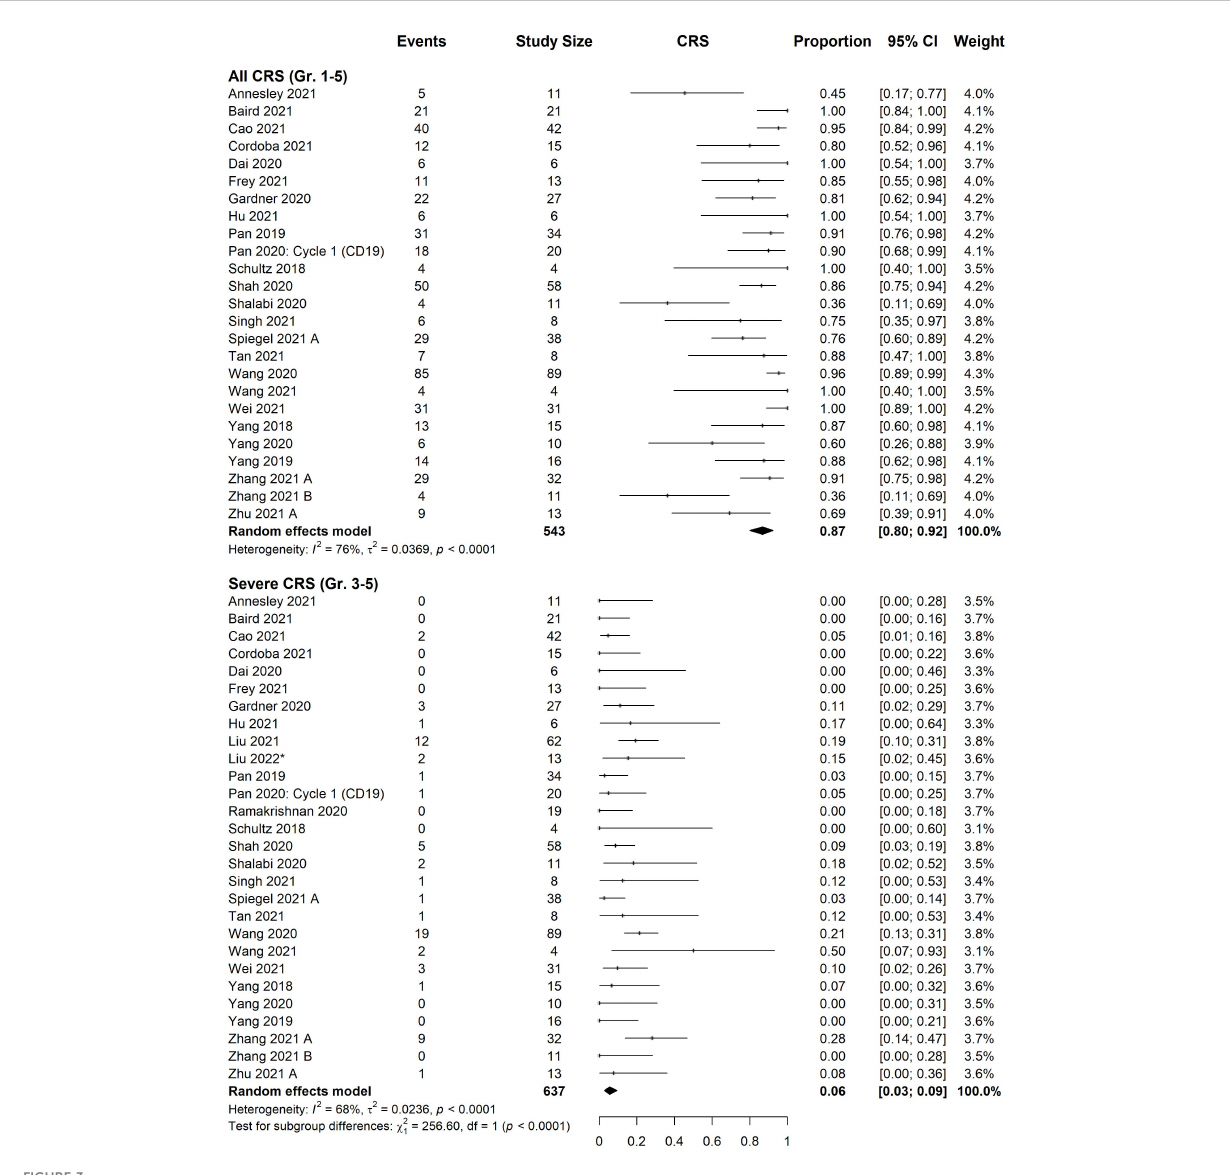
FIGURE 3 Forest plot of cytokine release syndrome rate organized by severity. Pooled estimate of effect, black diamond, was calculated for both all grades (1- 5) and severe grades (3-5). Pan 2020: cycle 1 (CD19) was excluded from analysis, although rates did not signi fi cantly differ from cycle 2 (18/20 all grades, 1/20